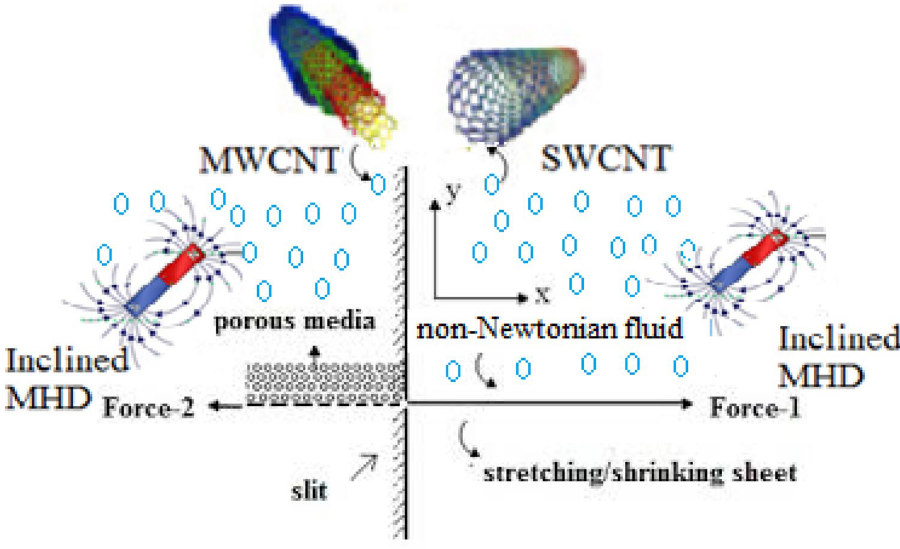
Figure 1. Schematic diagram of stretching